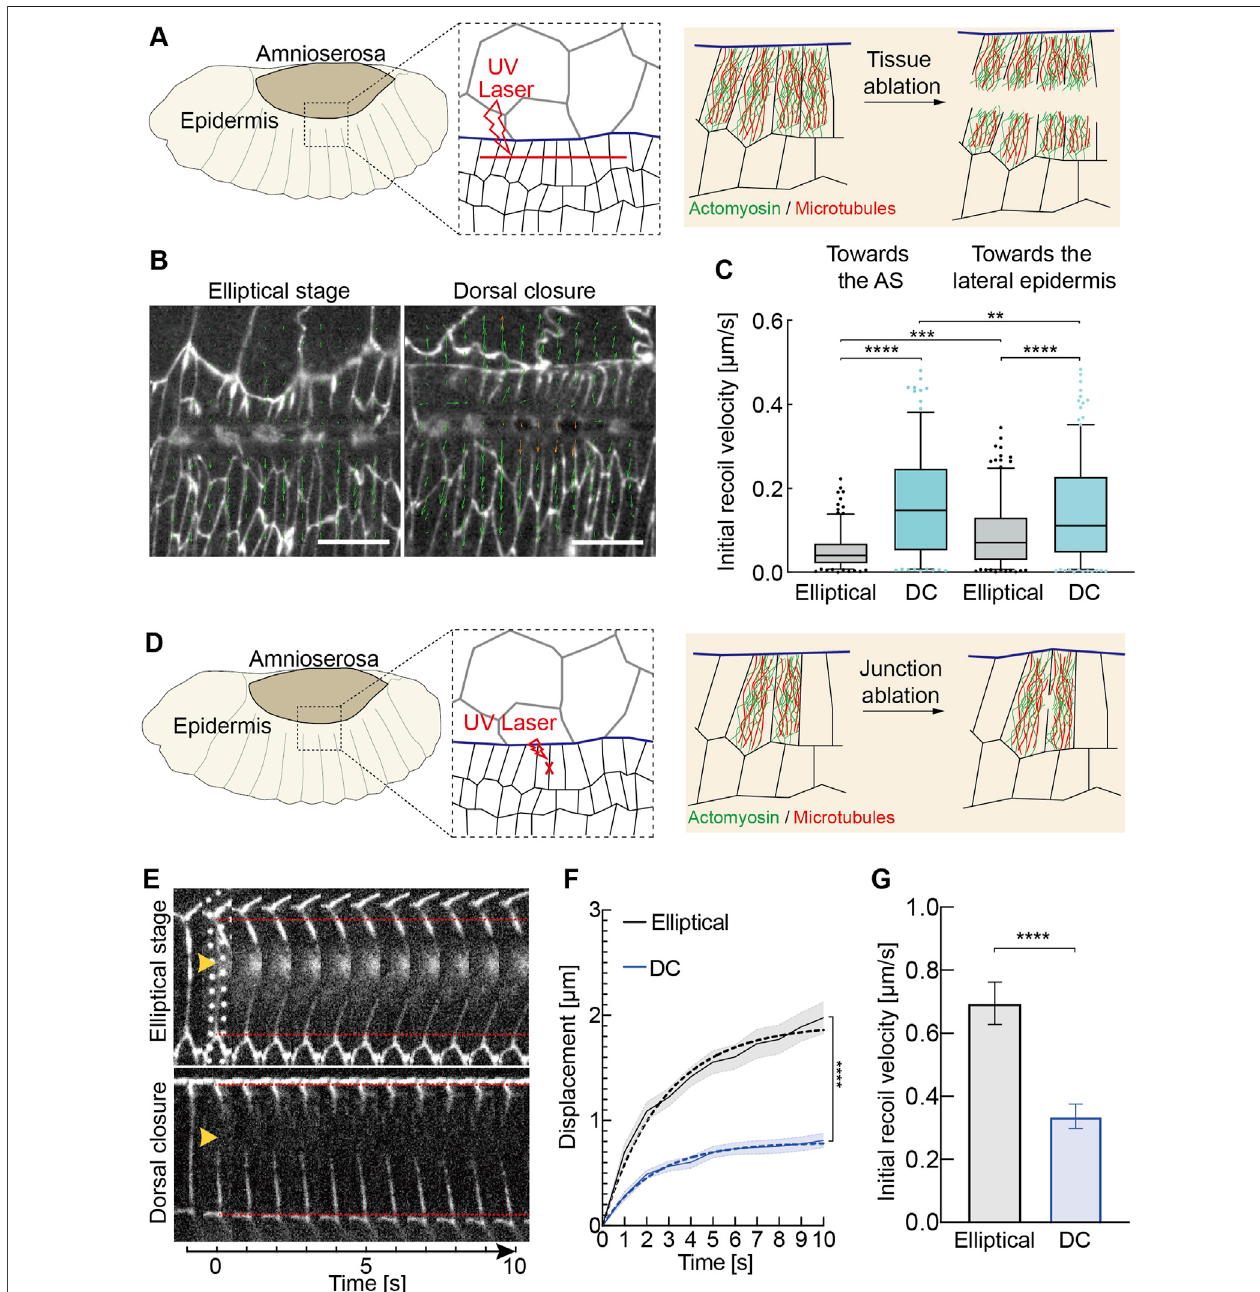
FIGURE 5 | Changes in tissue and junctional tension during morphogenesis. (A – C) Developmental up-regulation of tissue tension in the lateral epidermis (A) Experimental scheme oftissue laserablation in thelateral epidermis. A30 μ m linear ablation (red dashed line) was performed along theaxis inthe lateral epidermisin the region shown in the black dashed box. (B) Images from the time-lapse recording after the laser ablation. E-CadGFP outlines cells. The green arrow lines indicate the velocityvectorsperformedbyparticleimagevelocimetry(PIV)analysis.Thelengthofvectorsrepresentsthemagnitudeoftherecoilvelocity. (C) Quanti fi cationofthe recoilvelocityfromvectorhorizontally(axisorientation)andvertically(lateralorientation).Boxplotshowstheinitialrecoilvelocitiesaftertissueablation.Boxes,secondand third quartiles; whiskers, 95% con fi dence interval; horizontal line, mean. Dots are the data outside of con fi dence interval. Three independent experiments from three embryos in each stage, N = 192 particles from each stage toward the AS, and N = 213 particles from each stage toward the lateral epidermis. Two-way ANOVA estimates the p values between the particles toward the same directions (the AS or the lateral epidermis) from different stages. The Mann – Whitney test estimates the p values between particles toward the AS and the lateral epidermis from the same stages. ** p < 0.01, *** p < 0.001, and **** p < 0.0001. (D – G) Developmental down- regulationofinitialrecoilat individualjunctionsinthelateral epidermis. (D) Experimental schemeofjunctionallaserablation inthelateralepidermis.Asignaljunctioninthe dorsal-most epidermal (DME) cells along the lateral direction ablated is shown in red. (E) Kymographs of representative junction cuts shown in panel (D) . (F) Vertex